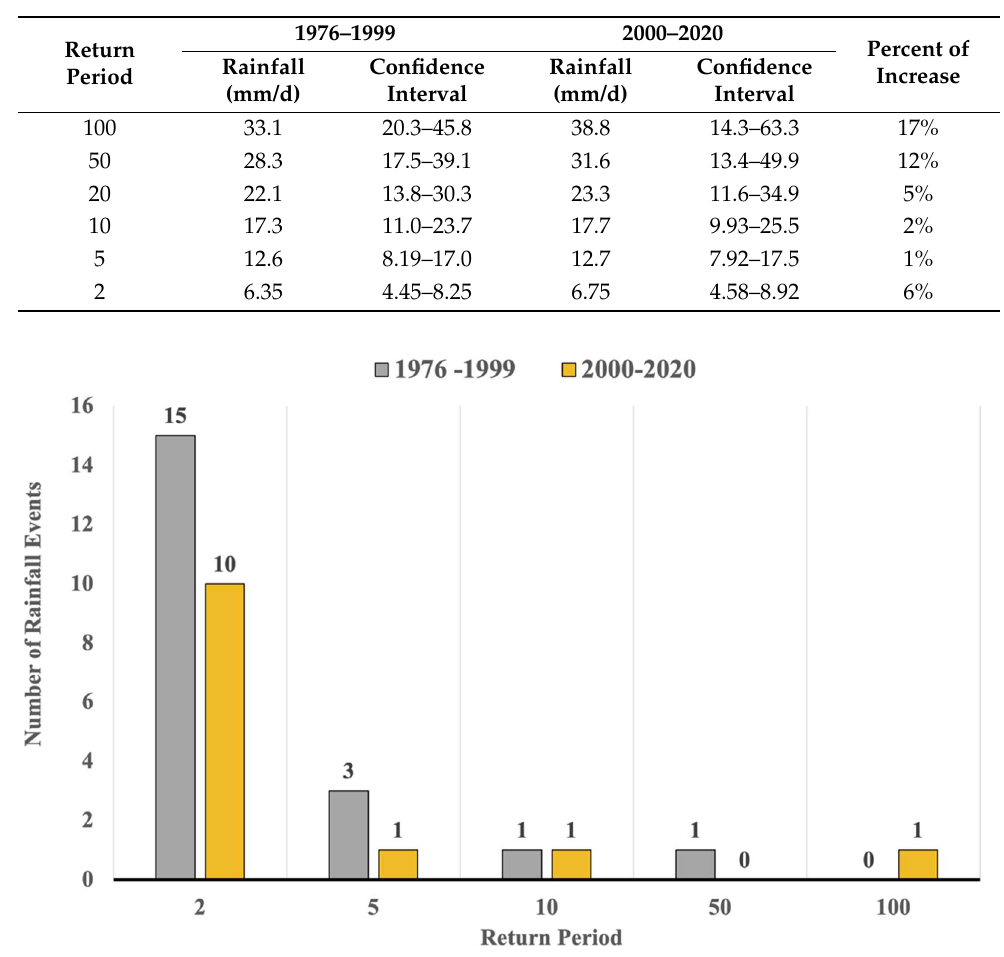
Figure 10. Total number of rainfall events occurred for each return period for two time periods (1976 to 1999 and 2000 to 2020).